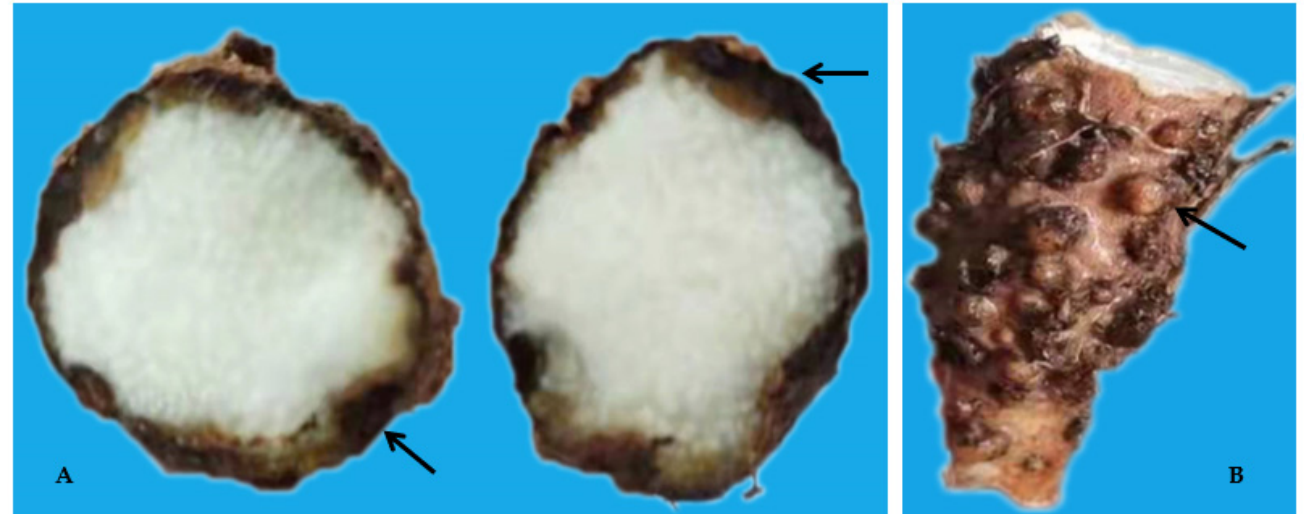
Figure 2. Mean population densities (MPD), and frequencies of occurrence (FO) of plant-parasitic nematodes species re- covered from roots/tubers of yam in nine localities of Jiangxi and Shandong provinces across south-east China during 2020/2021.